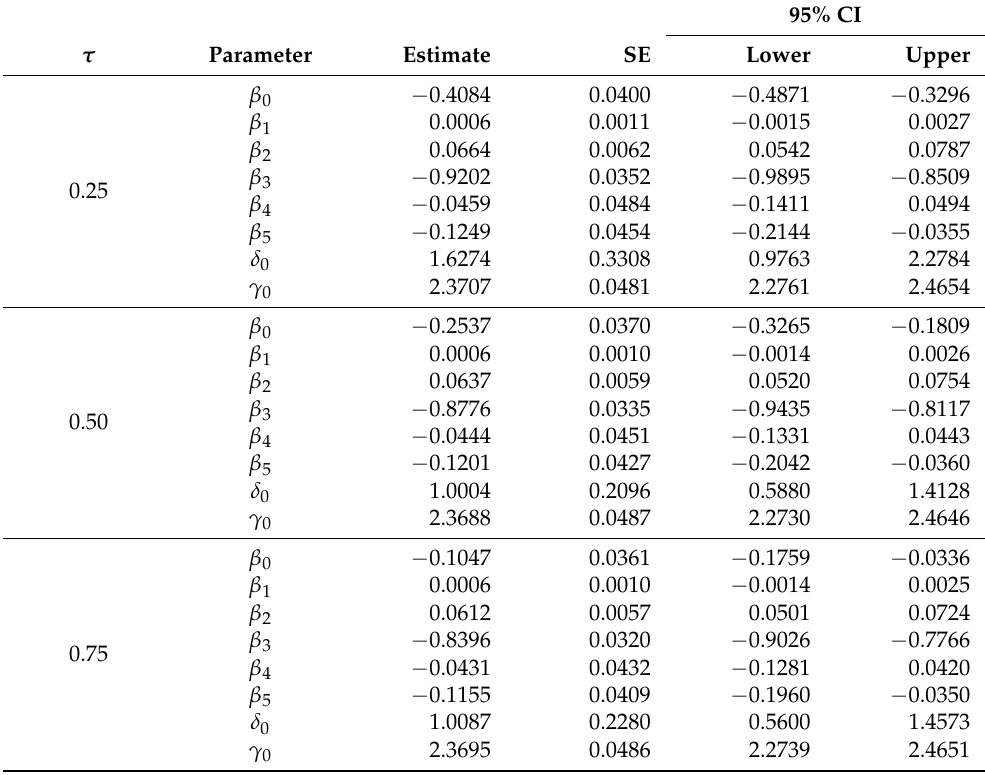
Table 11. ML estimates, SEs, and 95% CI for the indicated τ and parameter with data related to fat percentage at the